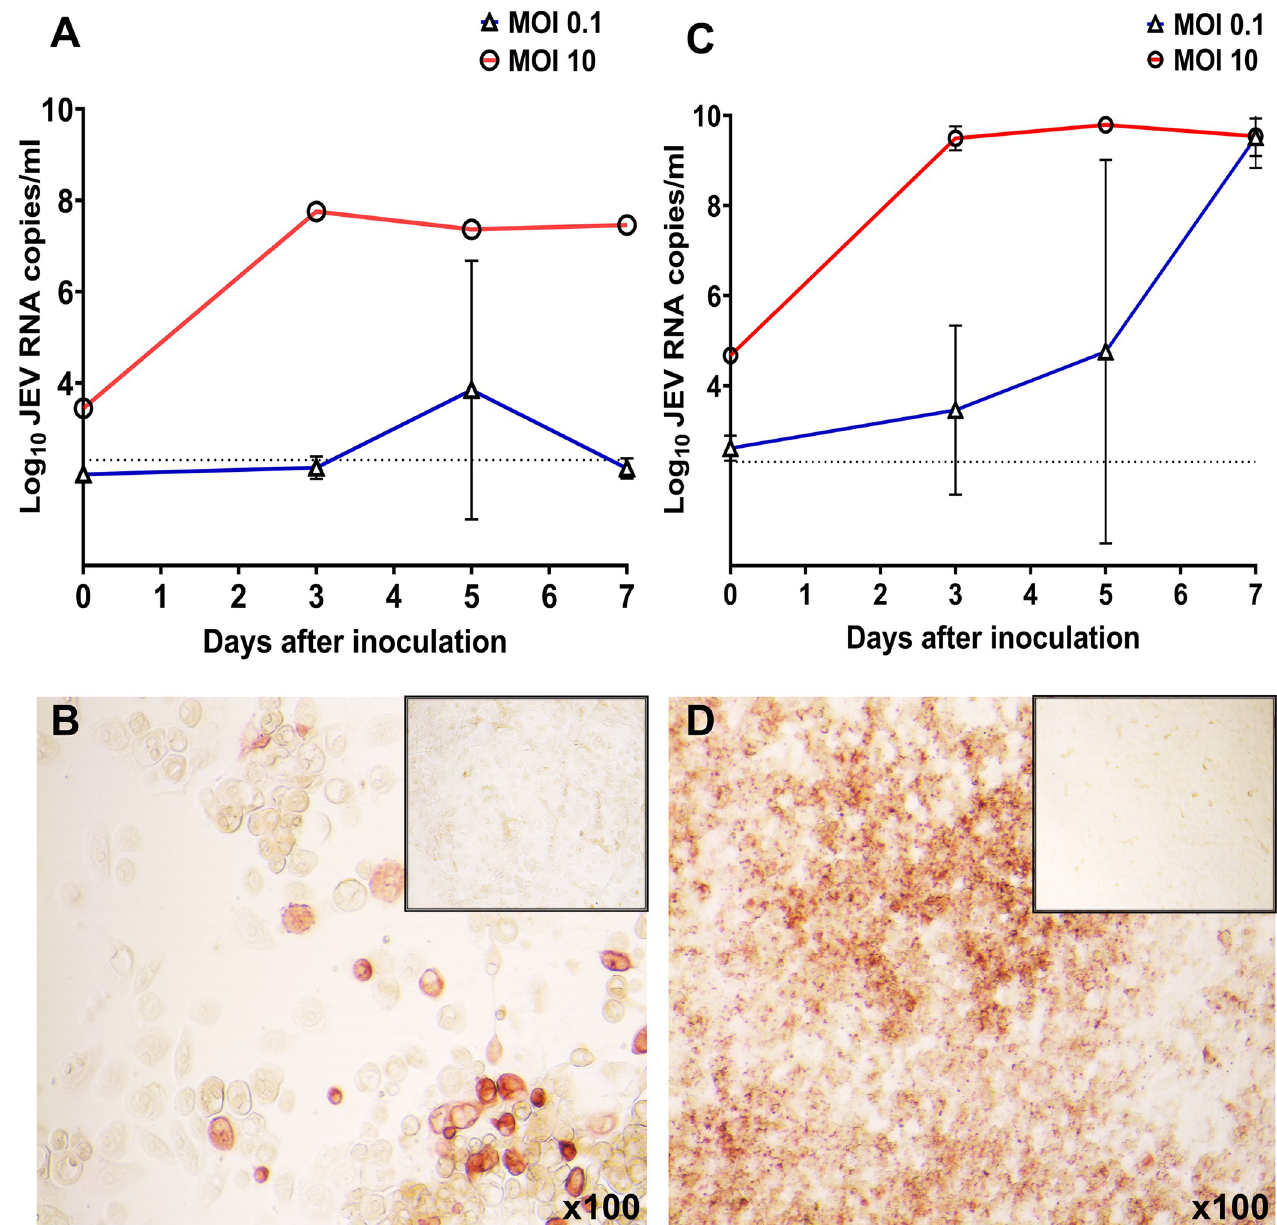
Fig 3. Japanese encephalitis virus causes persistent infection in human primary endometrial epithelial cells and trophoblast. ( A ) JEV infection kinetics in human primary endometrial epithelial cells. ( B ) Immunohistochemistry specific for the JEV envelope protein in human endometrial epithelial cells at 3 days after inoculation (MOI 10). The insert shows mock-inoculated cells. ( C ) JEV infection kinetics in human trophoblast—HTR-8/SVneo cells. ( D ) Immunohistochemistry specific for the JEV envelope protein in human trophoblast at 7 days after inoculation (MOI 10). The insert shows mock-inoculated cells. The dotted line on graphs represents the limit of